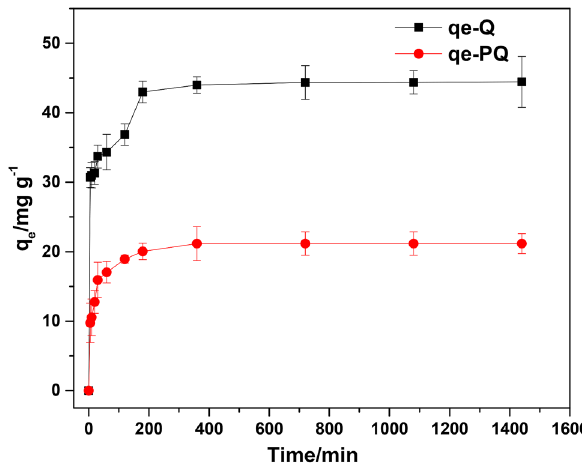
Figure 8. Effect of agitation time on the uptake of Cr(VI) by PQ and Q.